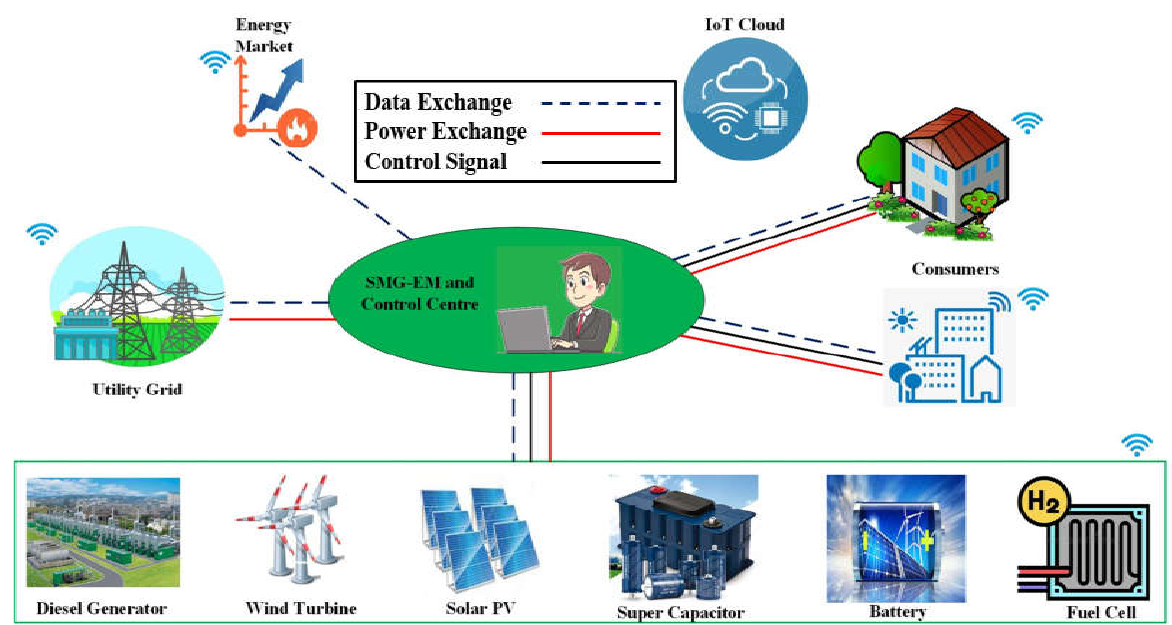
Figure 8. IoT-based optimal energy management and control for a MG.